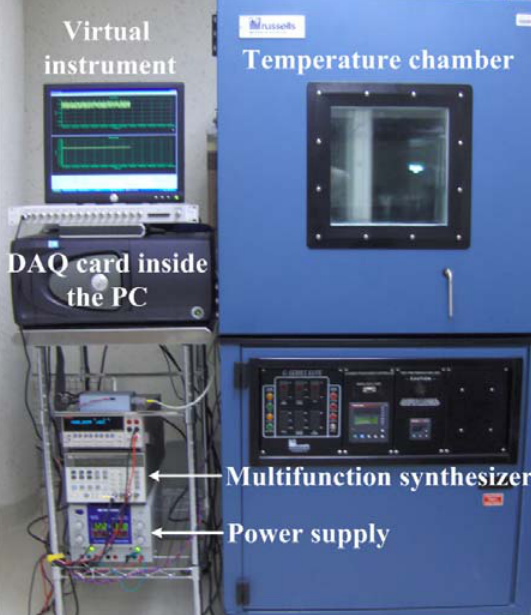
Figure 6. Experimental setup of the MEMS sensor signal processing. The PCB of the sensor is located inside the temperature